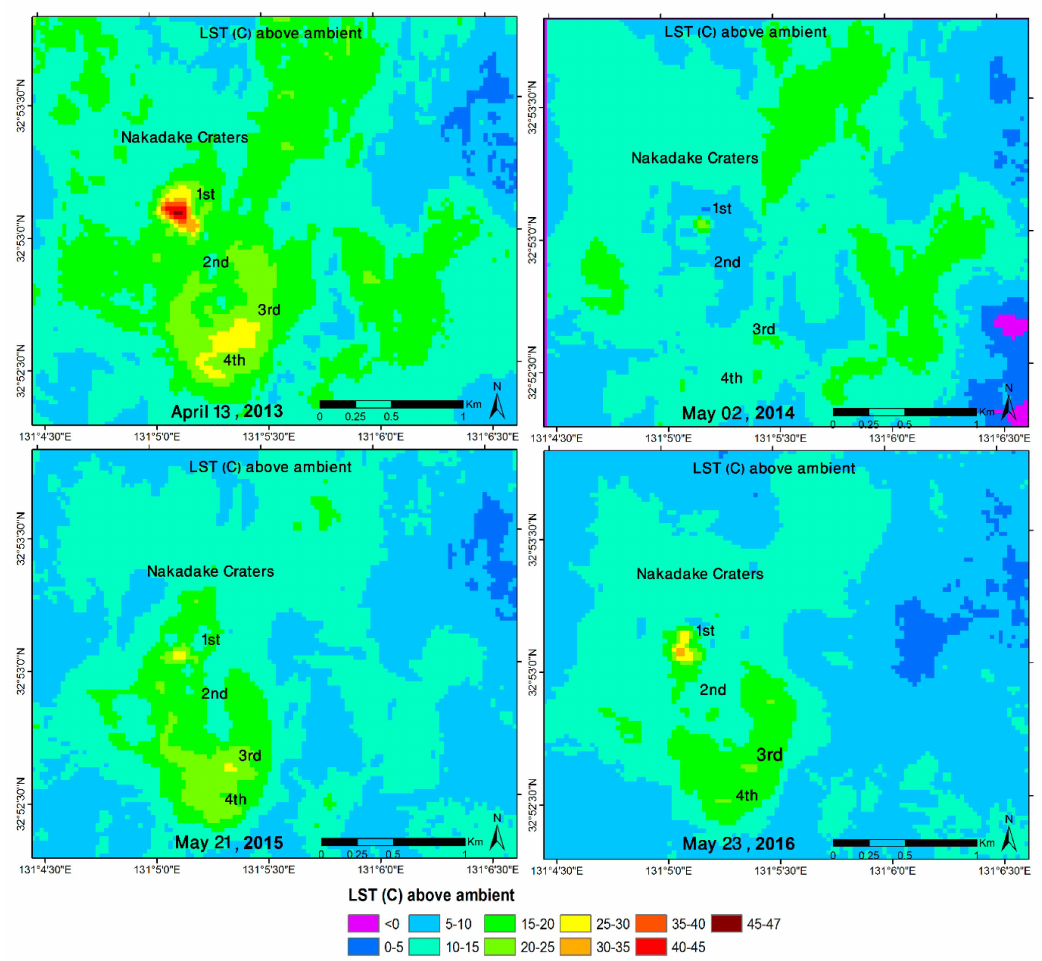
Figure 5. Thermal status of the study area shown using land surface temperature above ambient during the study